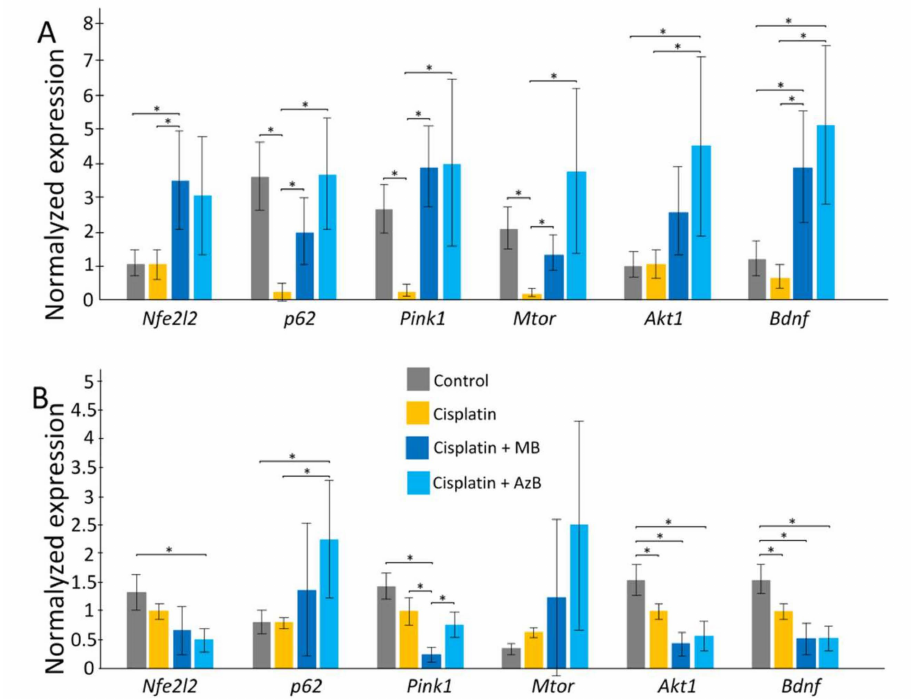
Figure 4. Expression of transcriptional factors in the ( A ) cortex, ( B ) hippocampus. The results expressed as means ± SEM. Control n = 11, Cisplatin = 6, Cisplatin + MB = 8, Cisplatin + AzB = 8. * p < 0.05, comparison of control group and treated groups using Tukey’s post-hoc